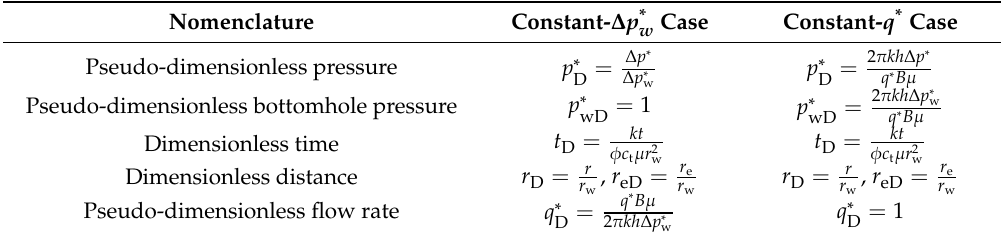
Table 2. Definitions of pseudo-dimensionless and dimensionless variables for vertical